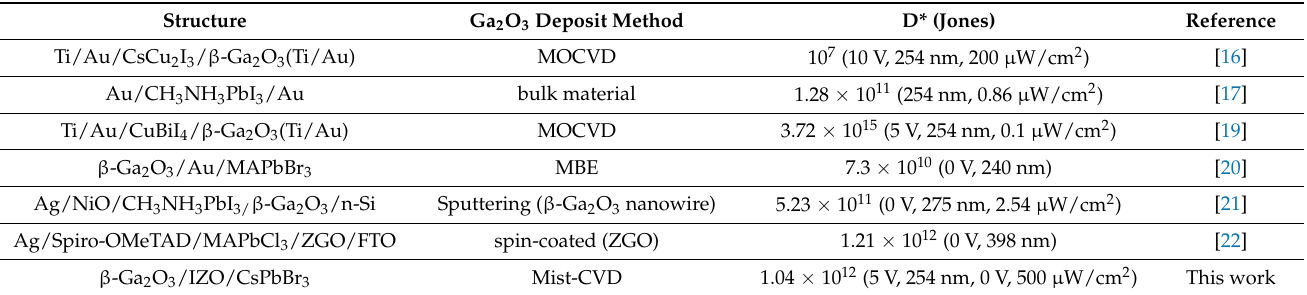
Table 3. Comparison of perovskite-/Ga 2 O 3 -based UV PDs reported.